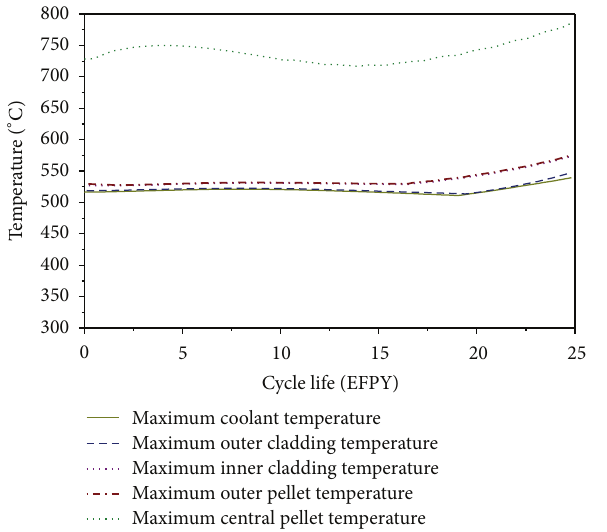
Figure 19: Influence of SiC f /SiC on Doppler